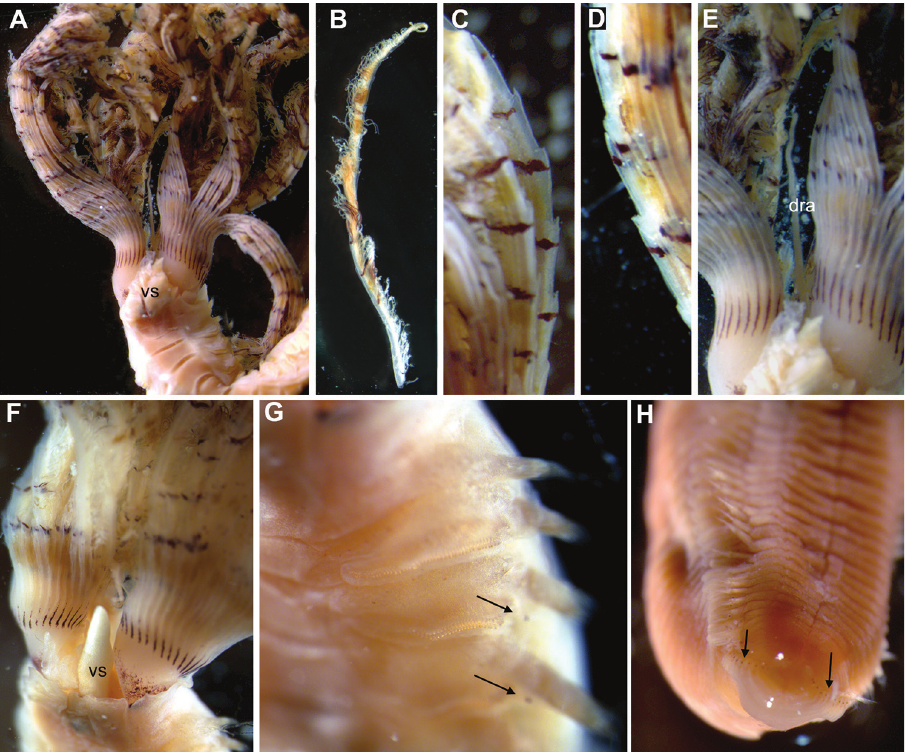
Figure 4. Pseudobranchiomma cf. P. orientalis AM W.32677, AM W.32679: Photographs. A Anterior end, ventral view B Detached radiole C Detail of lateral radiole, mid length D Detail of base lateral radi- ole E Detail of radiolar crown base with dorsal radiolar appendages F Detail of radiolar crown base with ventral sacs G Anterior thoracic parapodia H Posterior abdominal segments. dra, dorsal radiolar append- ages; vs, ventral sac; black arrows, interramal